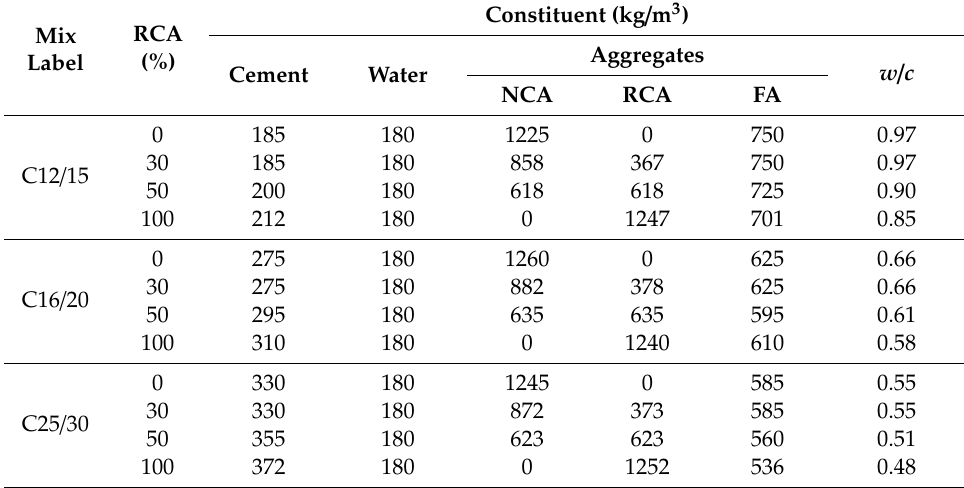
Table 2. Batching weight for 1 cubic meter of concrete with and without